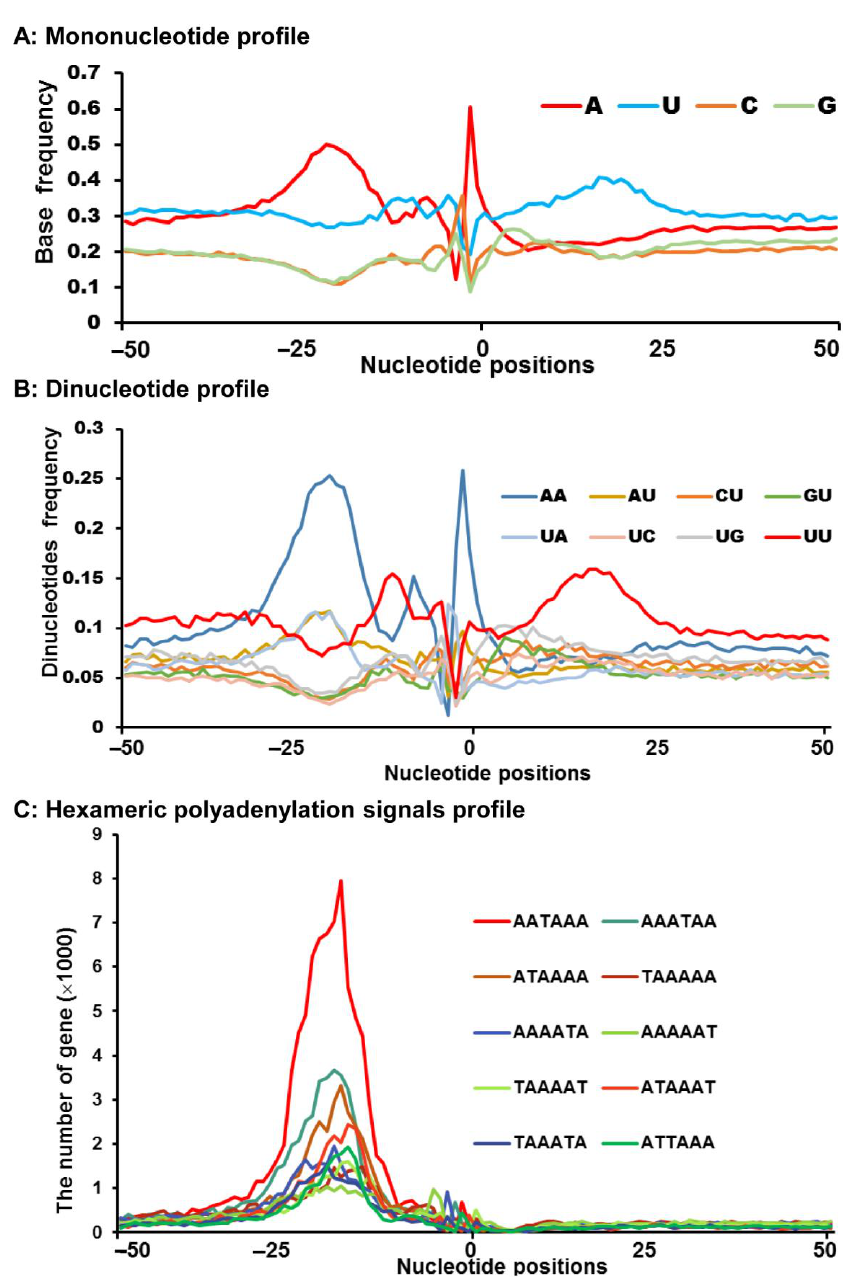
Figure 2. Sequence characterization around the cleavage site. ( A ) Distribution frequency of A, C, G, and U within 50 bp of the cleavage site of Spodoptera frugiperda . ( B ) Distribution frequency of the dinucleotides within 50 bp upstream and downstream of the cleavage site. Only top 8 dinucleotides were shown. ( C ) The number of hexamers within the 50 bp of the cleavage site. Only the top 10 motifs were shown. The number of genes is shown on the Y -axis. The position zero is the